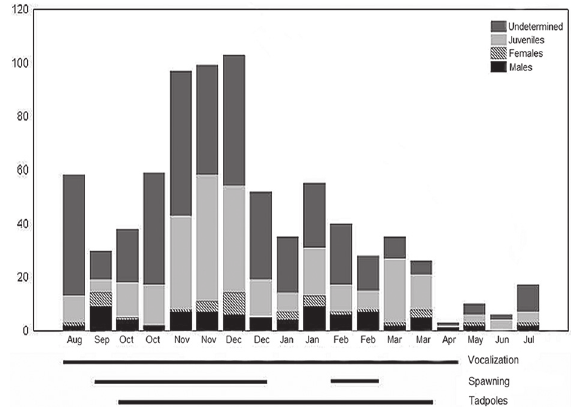
figure 1 - Abundance of Lithobates catesbeianus in two permanent water bodies in Faxinal do Soturno, southern Brazil, between August 2010 and July 2011. Lines represent the occurrence of vocalizations, spawns and tadpoles throughout the year.